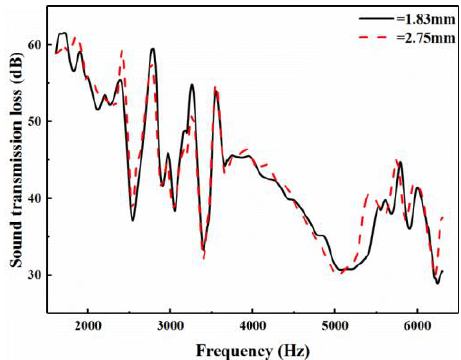
Figure 10. STL results obtained using cores with differently sized cells.